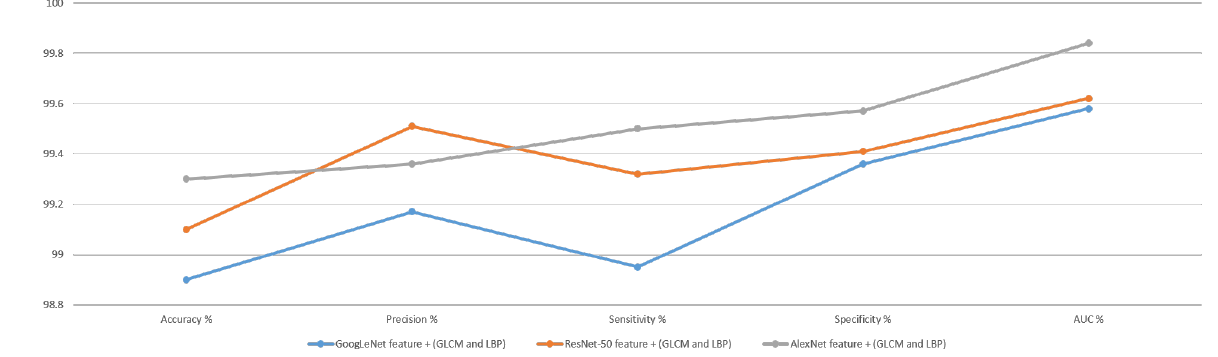
Figure 18. Performance of the ANN network based on hybrid features extracted.